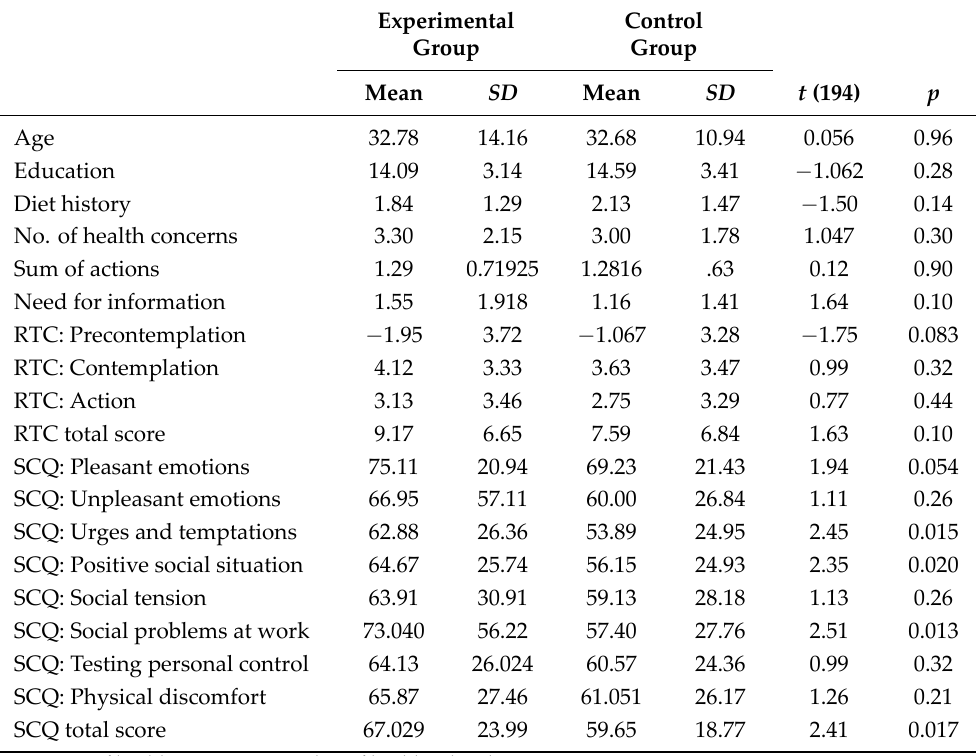
Table 4. Comparison of group characteristics in the second